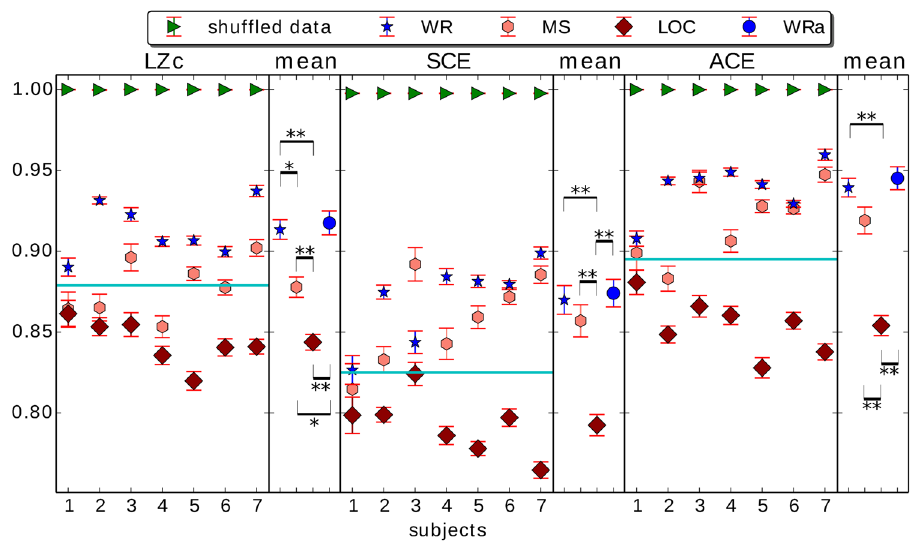
Fig 7. LZc, SCE and ACE computed as averages over multiple 10sec segments of EEG of the 7 subjects before and during anaesthesia. States shown are wakeful rest (WR) before propofol, mild sedation (MS), LOC and wakeful rest emerging from propofol sedation (WRa, not shown for single subject results). Measures are computed across 25 channels spread evenly across the whole cortex. The measures score highest for shuffled WR data, and consistently across subjects higher for WR as opposed to LOC. Error bars indicate standard error across segments, cyan horizontal lines are example thresholds for each of the measures, separating WR from LOC for all 7 subjects. For each single subject plot, the mean and standard error across its 7 values per state is displayed in the narrow plot to its right, with the title ‘ mean ’ . For these mean values across subjects, significant differences between state pairs are shown by a double asterisk if p < 0.01 and a single asterisk if p < 0.05 (Wilcoxon rank sum test, FDR corrected for multiple comparison). See Table 1 for effect size comparison.